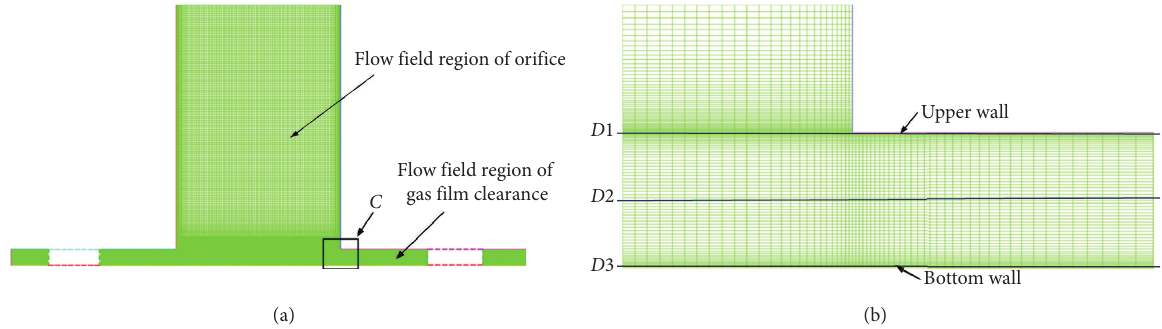
Figure 4: Schematic diagram of the area division for the outlet of the orifice. (a) Grid division; (b) local magnification of grid at C.